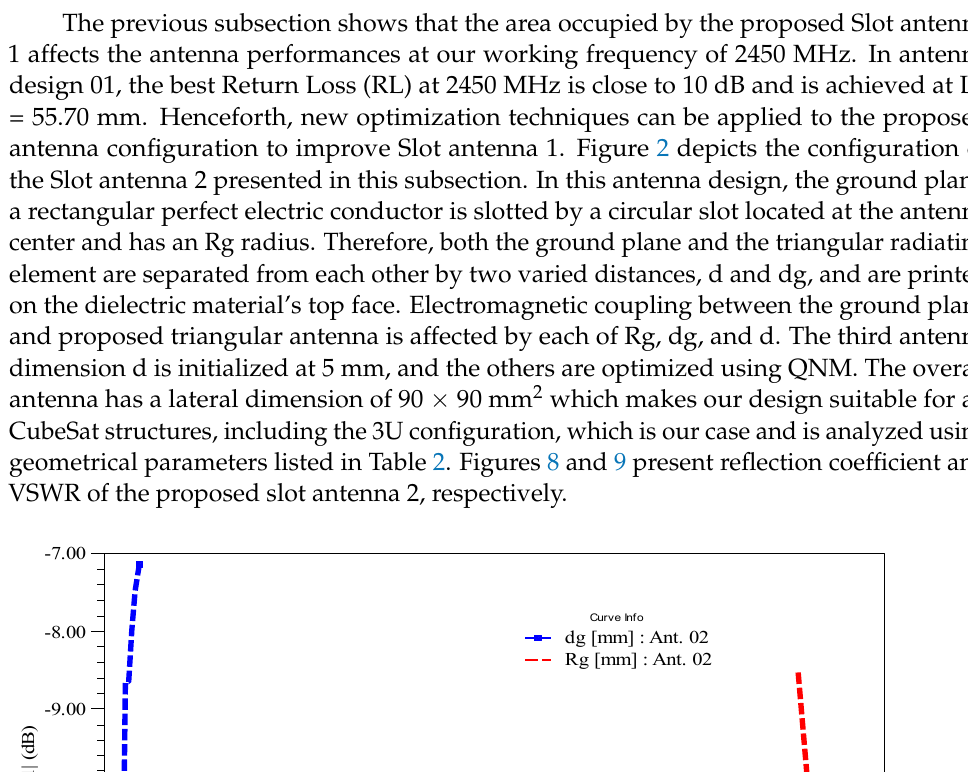
Figure 7. Real part of input impedance of Slot antenna 1 at 2450 MHz versus Lb (mm).